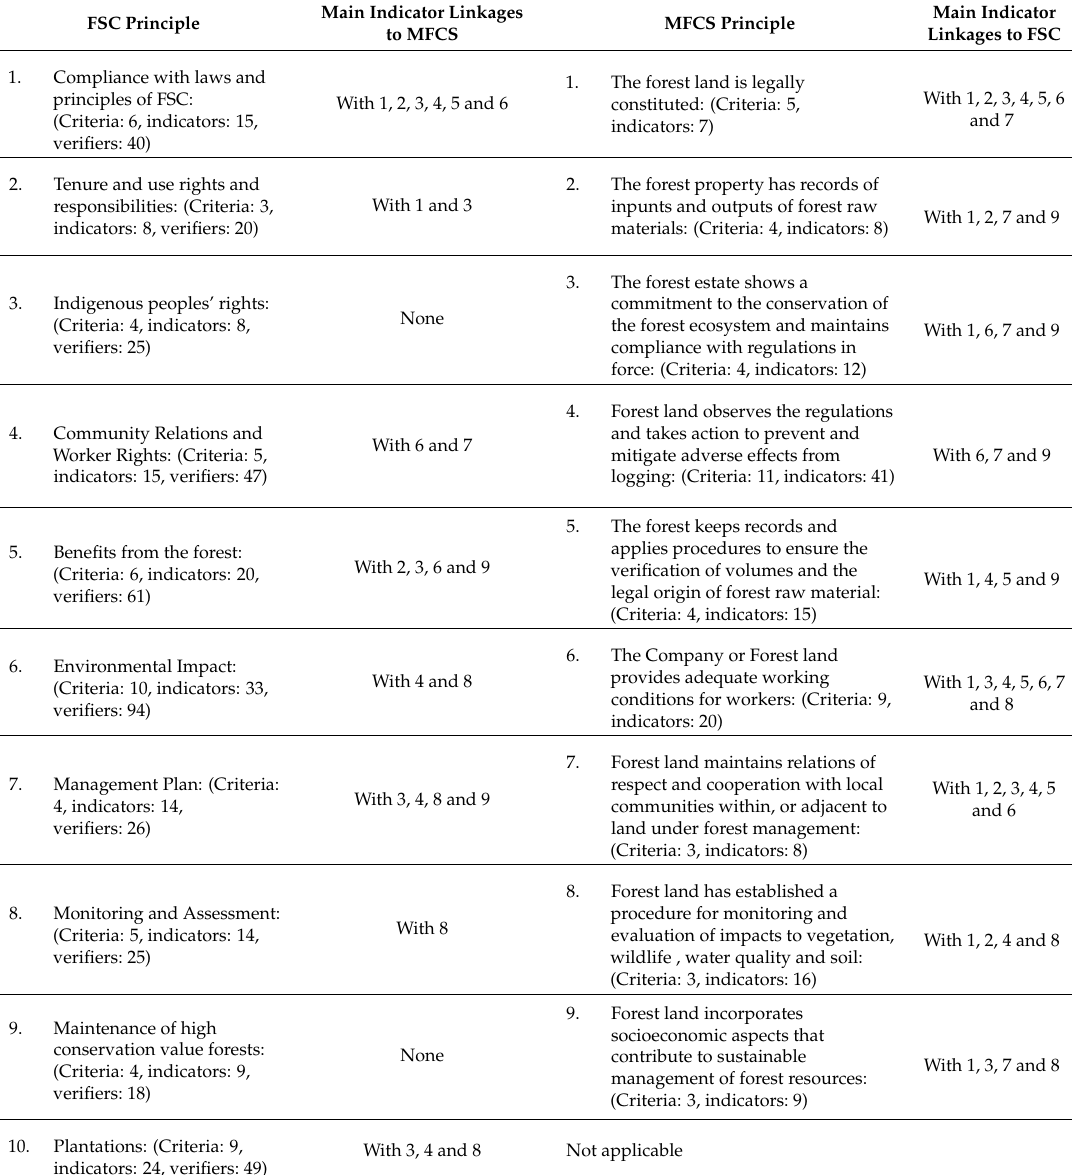
Table 3. Comparison of Specific Certification Standards between FSC and MFCS in